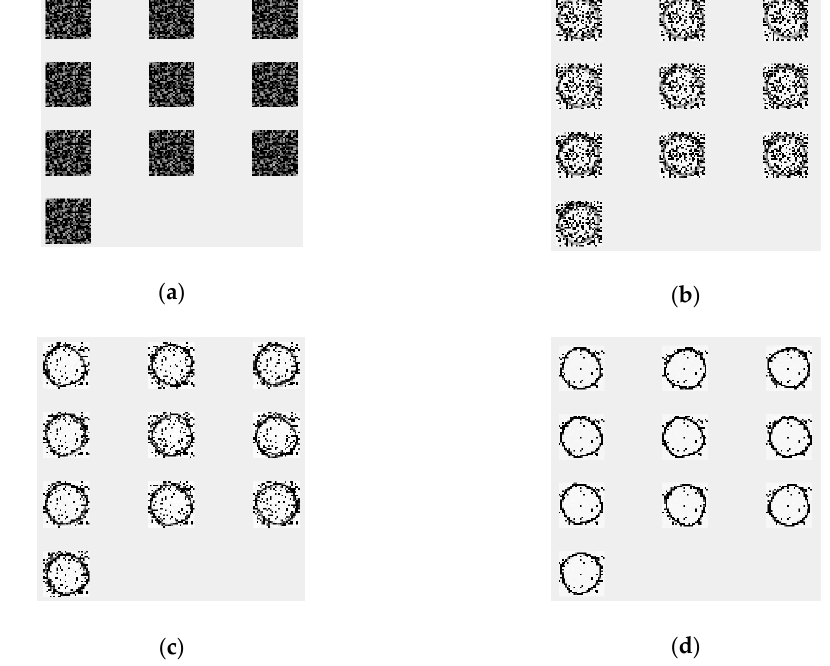
Figure 11. Selected training stages from 6000 iterations for the input gesture “circle”. This figure only